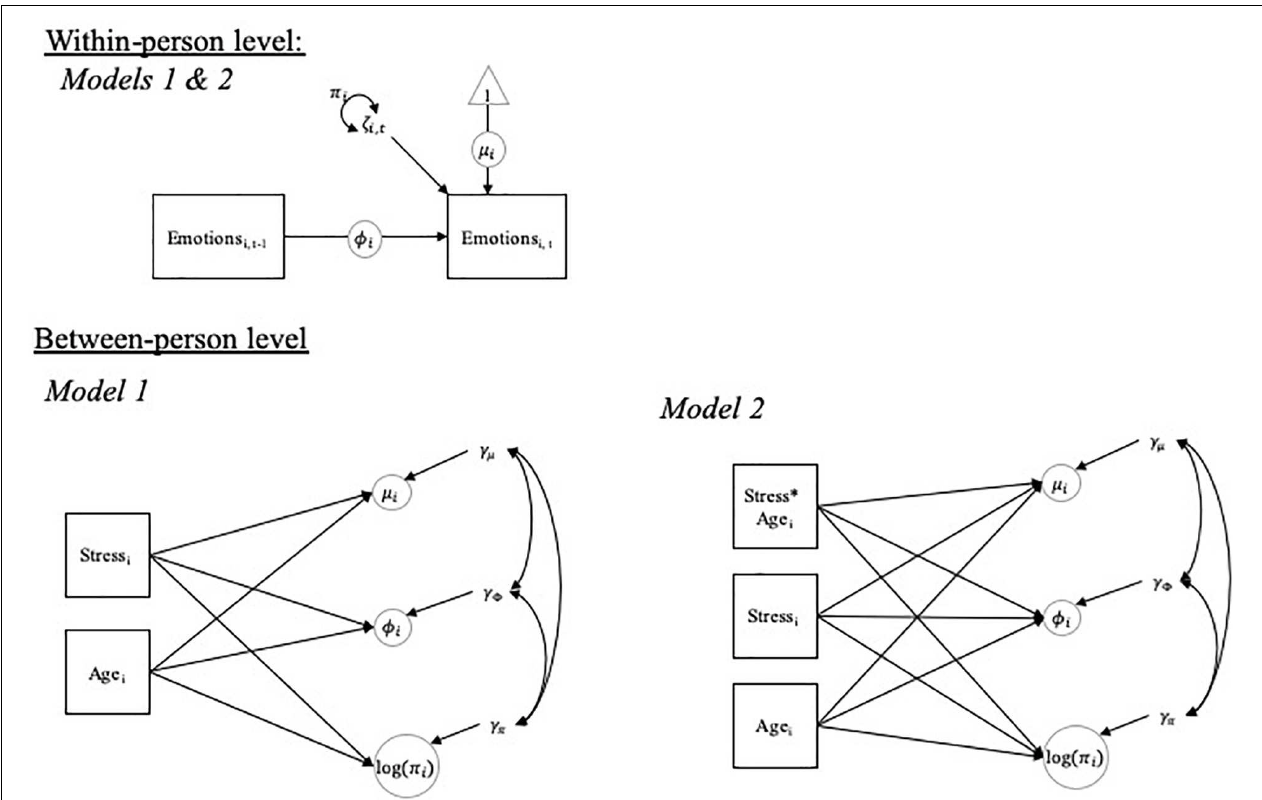
FIGURE 1 | Multilevel DSEM model.